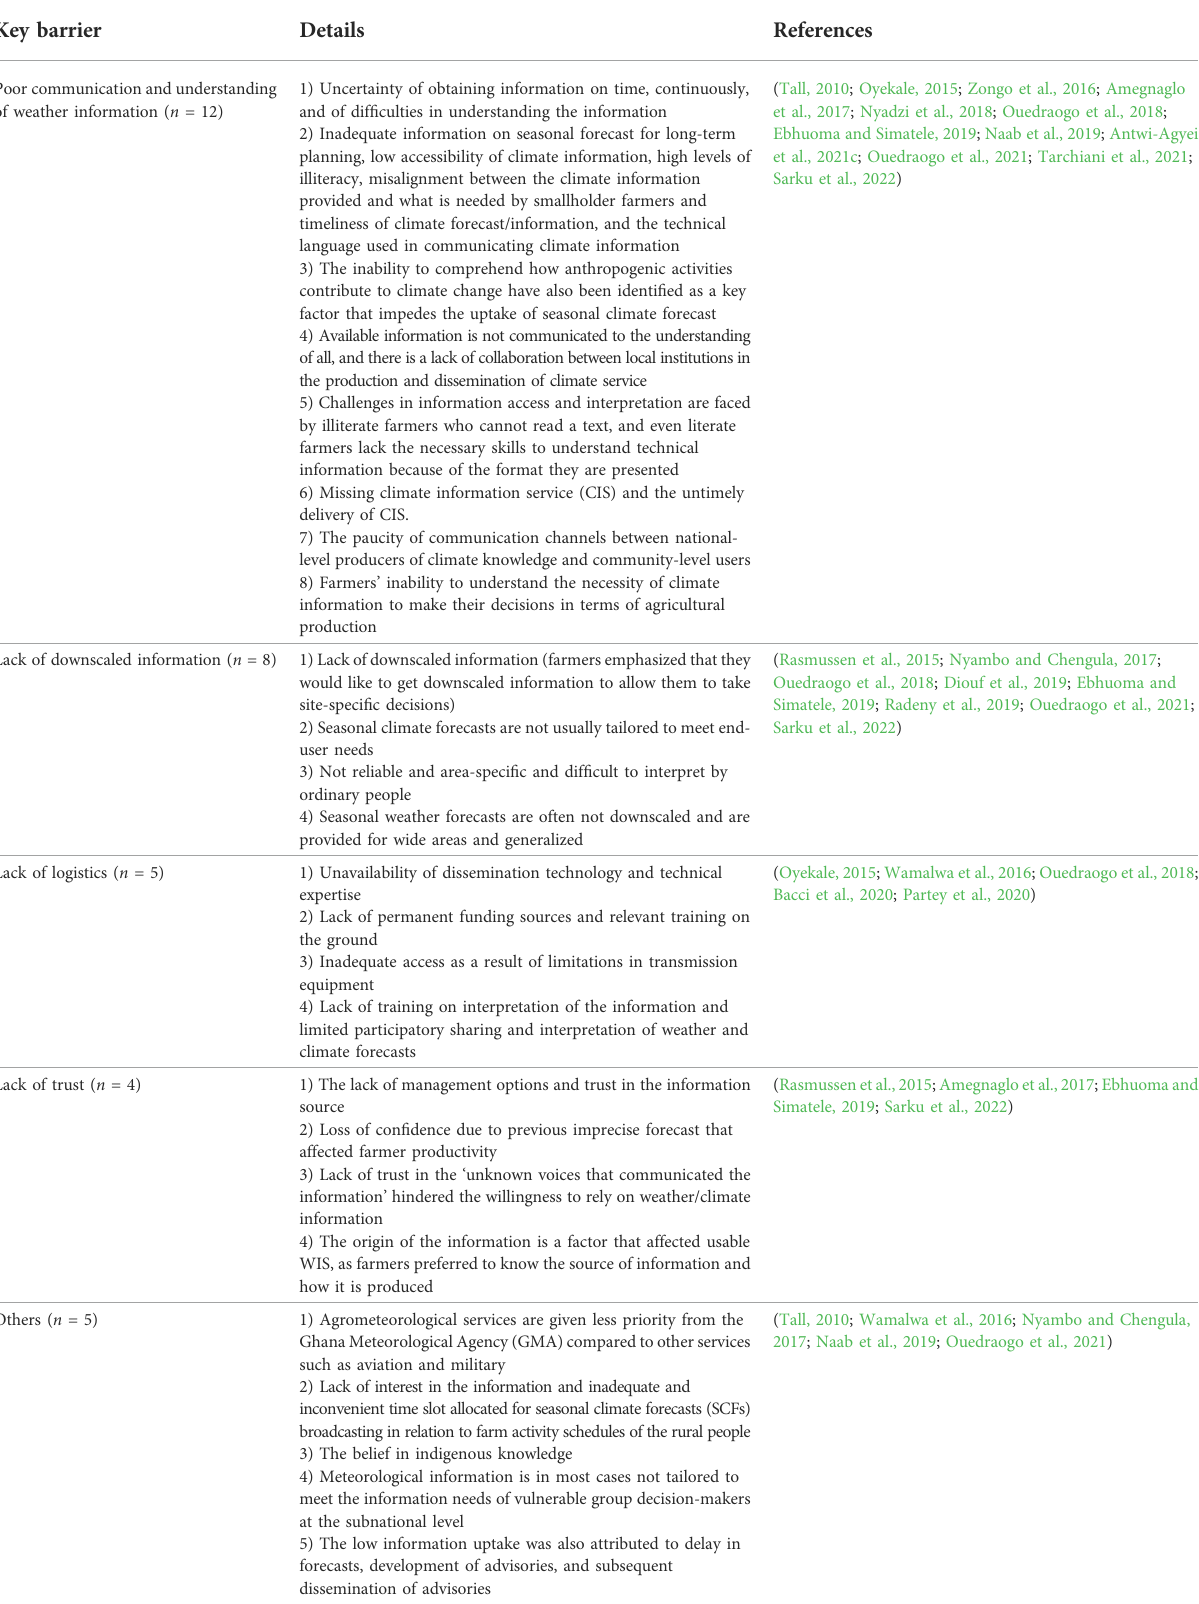
TABLE 4 Summary of key barriers to the uptake of weather or climate information. Key